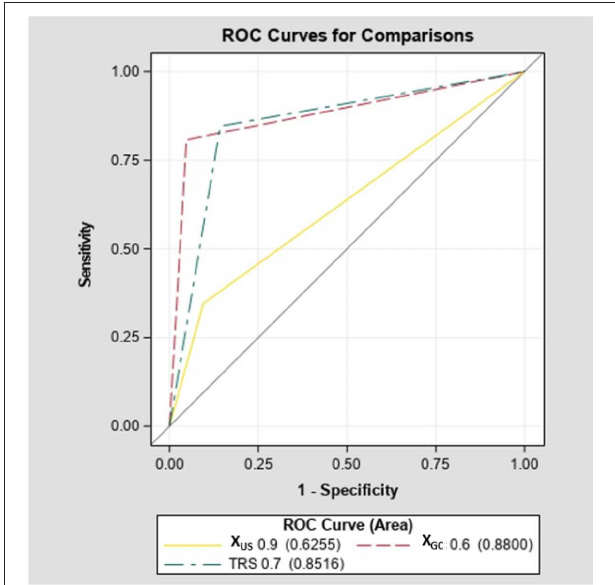
FIGURE 4 | Comparison of ROC curves-diagnostic accuracy of X US , X GC, and TRS.